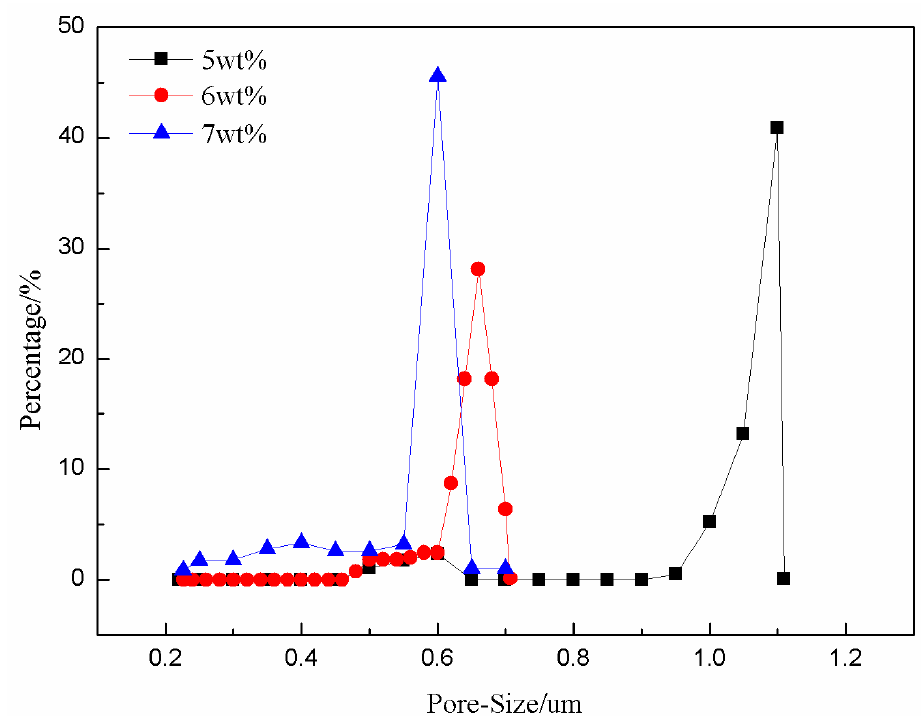
Figure 6. Pore-size distribution of the ceramic membrane with different solid contents.